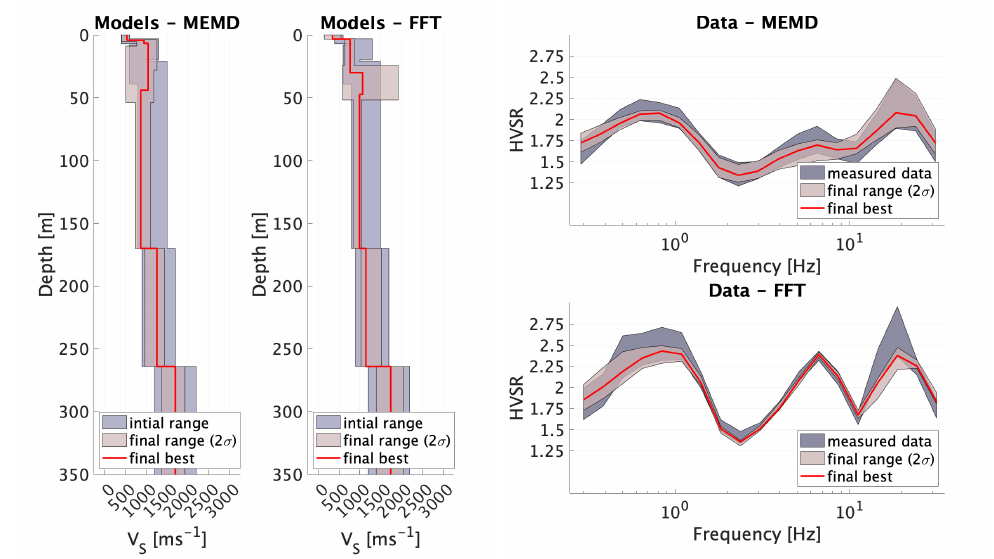
Figure 8. Model results and data fit for the inversion of EJDN data processed by MEMD and FFT.